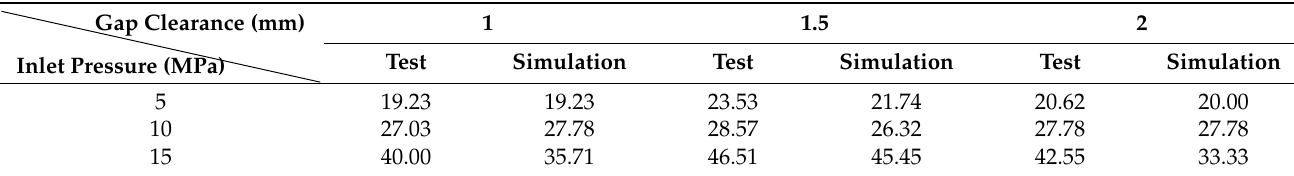
Table 6. Frequencies of cavitation surge for original suction cup (unit: Hz).